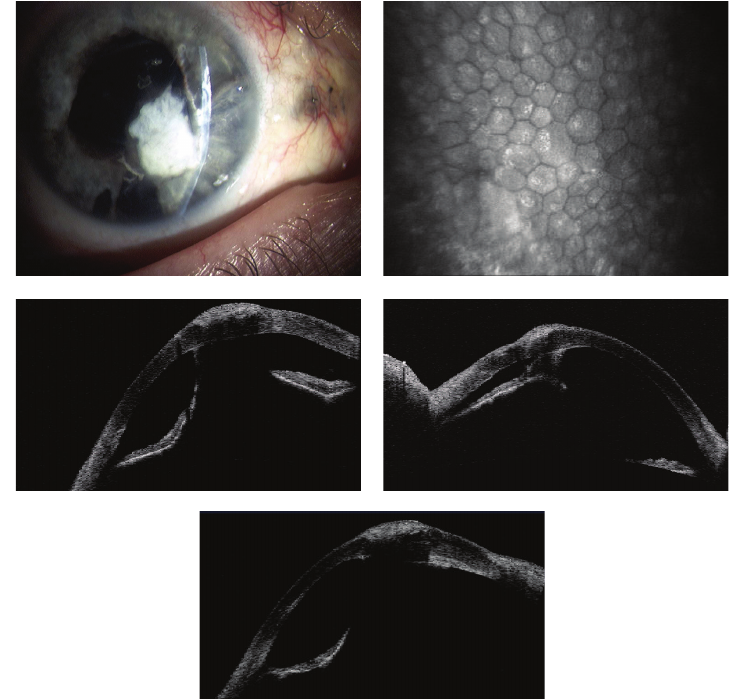
Figure 9: Corneal scar with processed pericardium graft and iris adhesions.